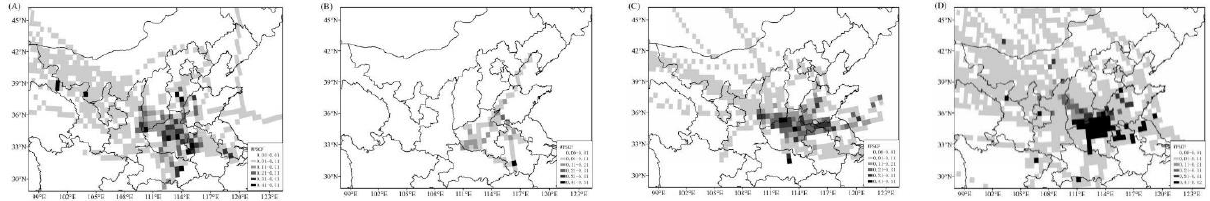
Figure 6 Distribution characteristics of PM 2.5 in WPSCF analysis in Zhengzhou during